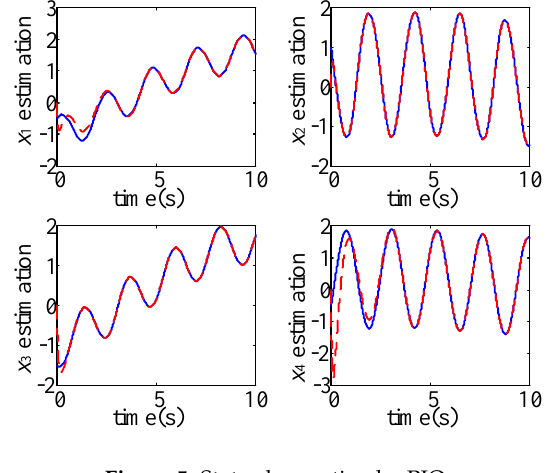
Figure 5. State observation by PIO. Appl. Sci. 2017 , 7 , 67